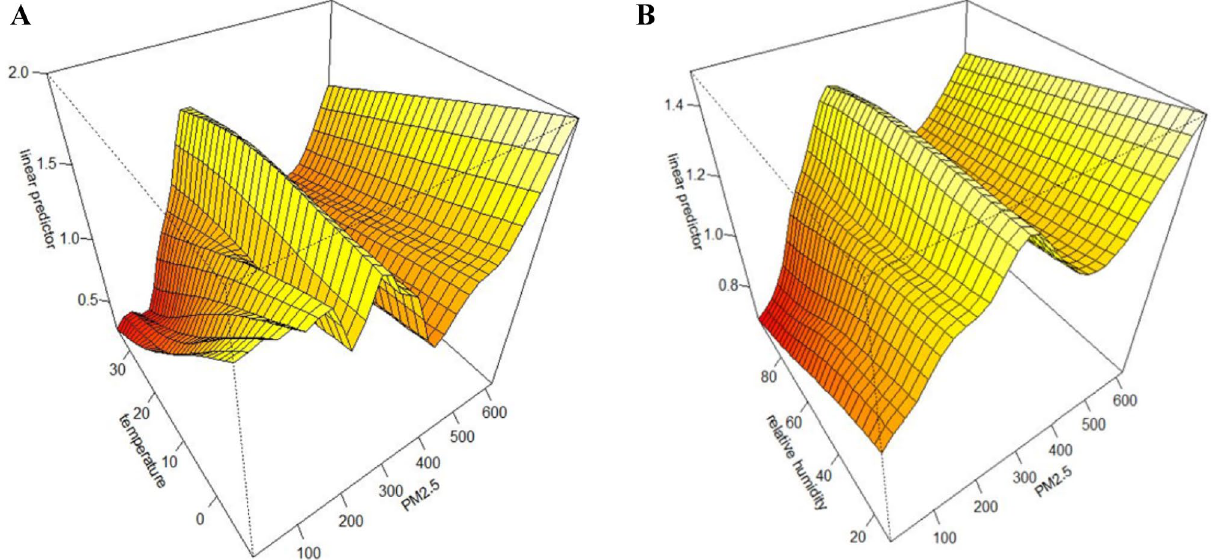
Figure 4. The interaction of PM 2.5 and meteorological variables on AECOPD cases at present day in Shijiazhuang China, 2015–2018, ( A ) the interaction of PM 2.5 with temperature; ( B ) the interaction of PM 2.5 with relative